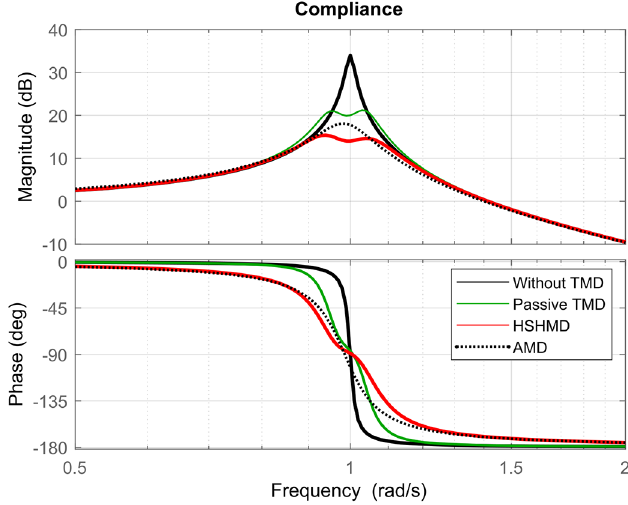
Fig. 5. Frequency Response Functions x 1 /F 1 of the closed loop